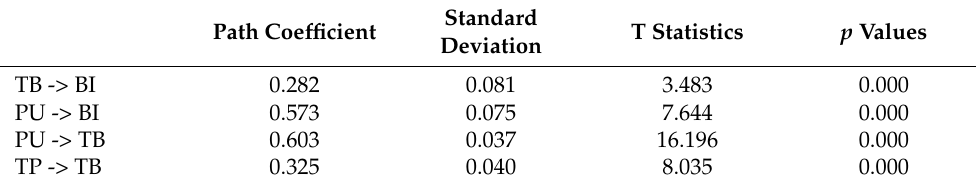
Table 7. Results for direct relationships (Complete sample).